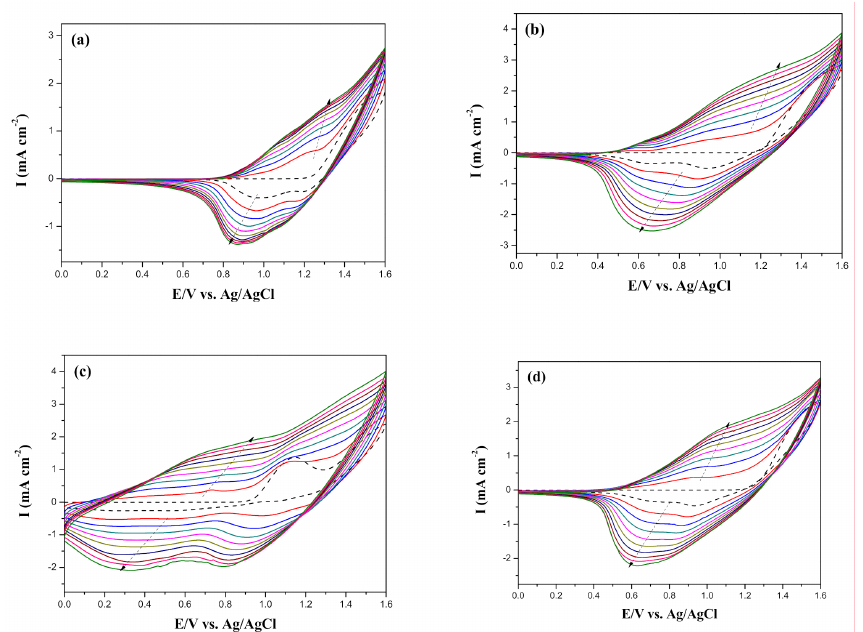
Figure 4. Electrochemical syntheses of ( a ) PBPBC, ( b ) P(BPBC- co -BT), ( c ) P(BPBC- co -CDT), and ( d ) P(BPBC- co -CDTK) in 0.2 M LiClO 4 of ACN/DCM solution (ACN/DCM = 4:1, by volume) at 100 mV · s − 1